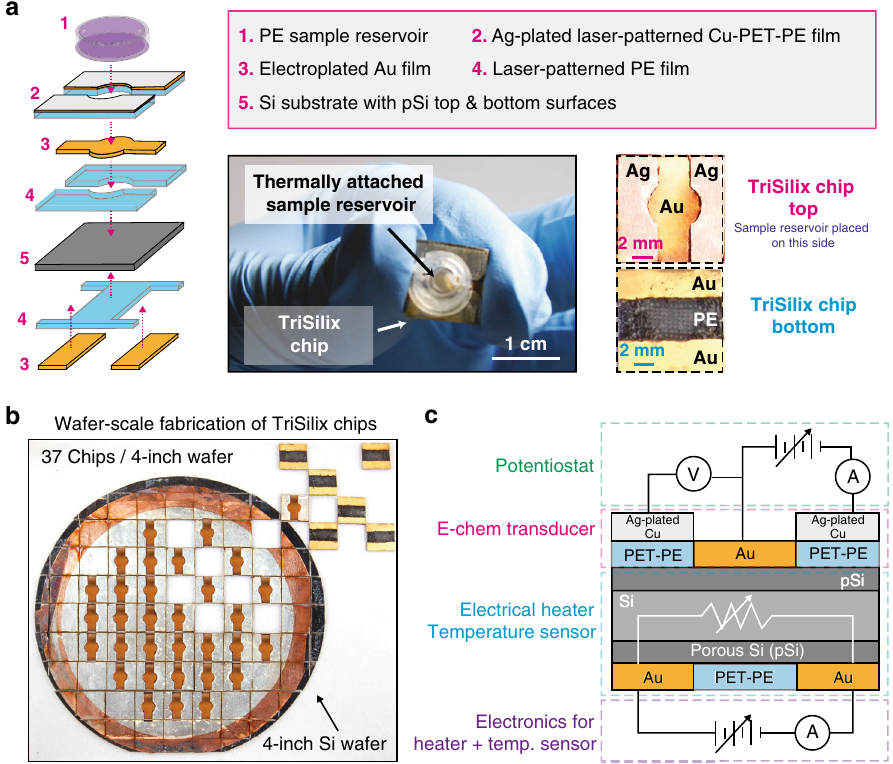
Fig. 1 Features of the proposed device (TriSilix). a Schematic illustration of construction of a TriSilix chip and photographs of the actual device. b Wafer- scale fabrication of TriSilix using a 4-inch Si wafer. Each wafer yields 37 chips. c Schematic illustration of the functional building blocks of TriSilix that provide trimodal operation for integrated nucleic acid ampli fi cation and